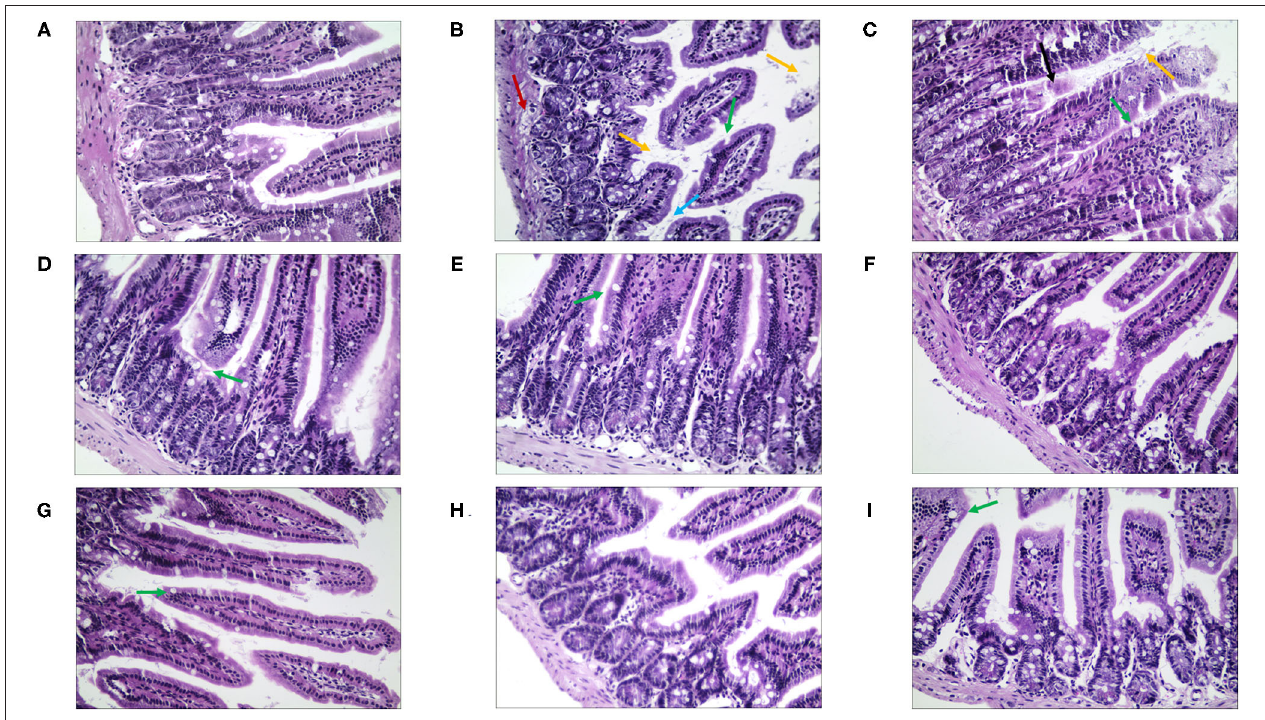
FIGURE 9 | The morphological and histopathological changes (H&E, × 50 magnification) of the jejunum tissues in diarrhea mice. (A) Normal control (NC) group, (B) model control (MC) group, (C) positive control (PC) group, (D) QJC group, (E) quercetin group, (F) kaempferol group, (G) luteolin group, (H) scutellarein group, and (I) stigmasterol group. Yellow arrow: exfoliated mucosal epithelial cells; blue arrow: intestinal crypts; green arrow: goblet cells; red arrow: loose connective tissue; original magnification: × 50, n = 5 per